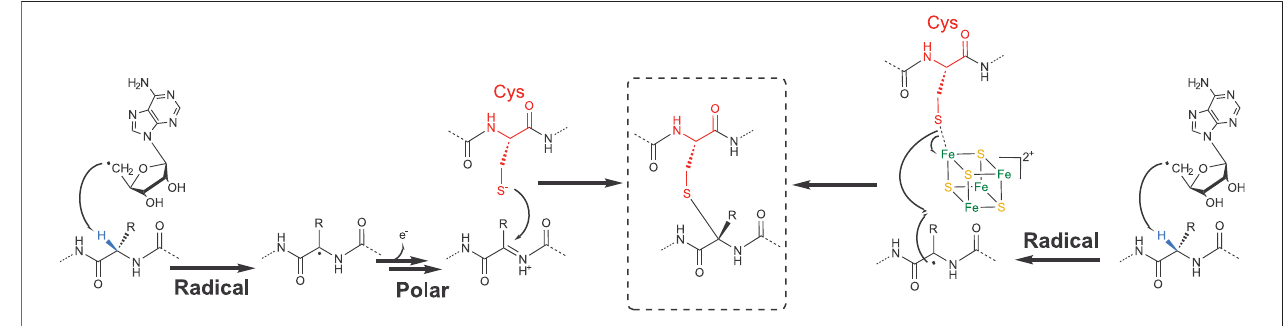
FIGURE 4 | Radical and polar alternatives for the formation of C α – thioether